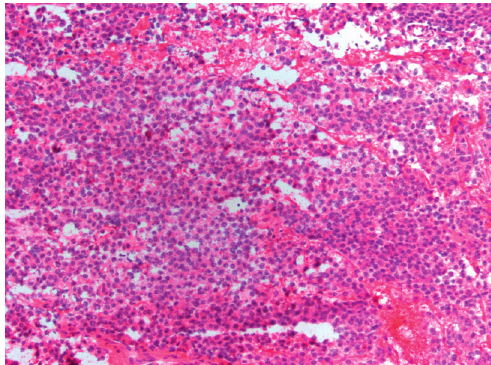
Figure 3: Intraoperative frozen section evaluation showing a homogeneous population of tumor cells with round nuclei, indistinct nucleoli, and cytoplasmic granules (200x